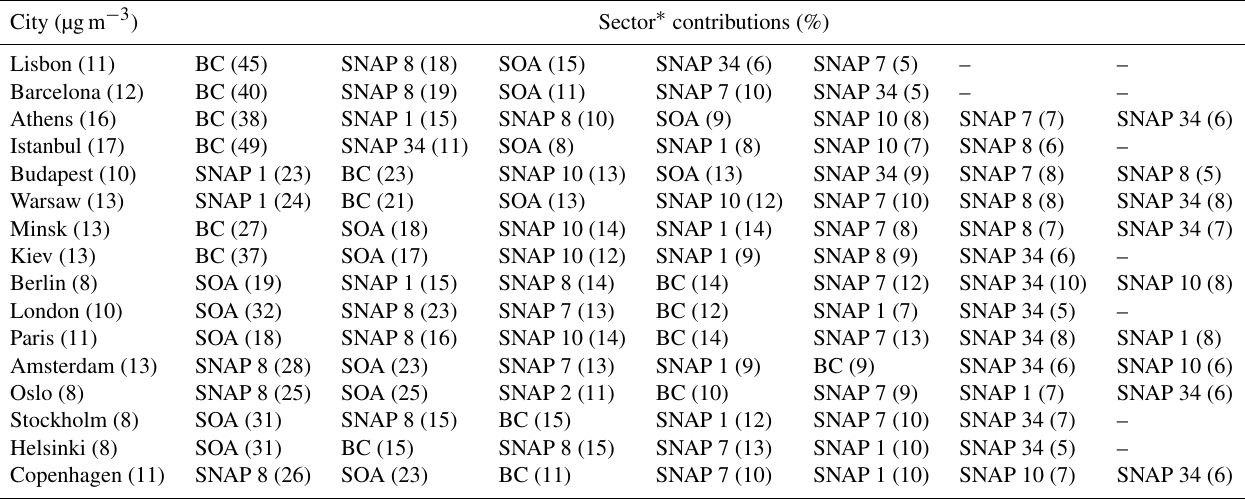
∗ See Table 1 for anthropogenic (SNAP) sector descriptions. Table 7. Sectors contributing 5% or more to summertime monthly mean PM 2 . 5 concentrations. Sector contributions in percentages are shown in